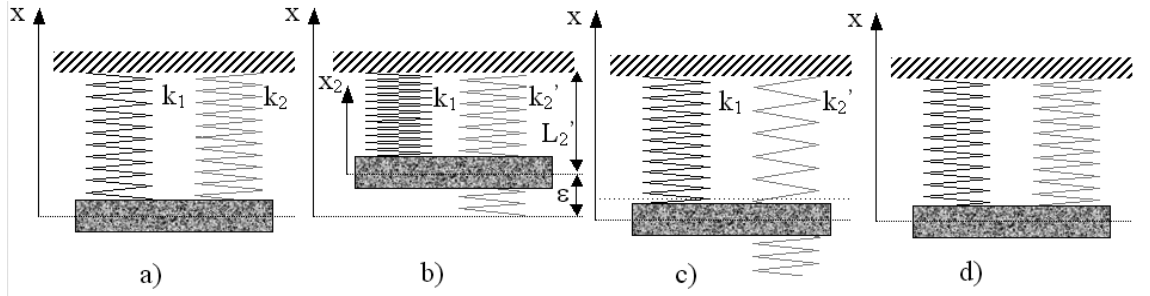
Fig. 1. Mass – two-springs